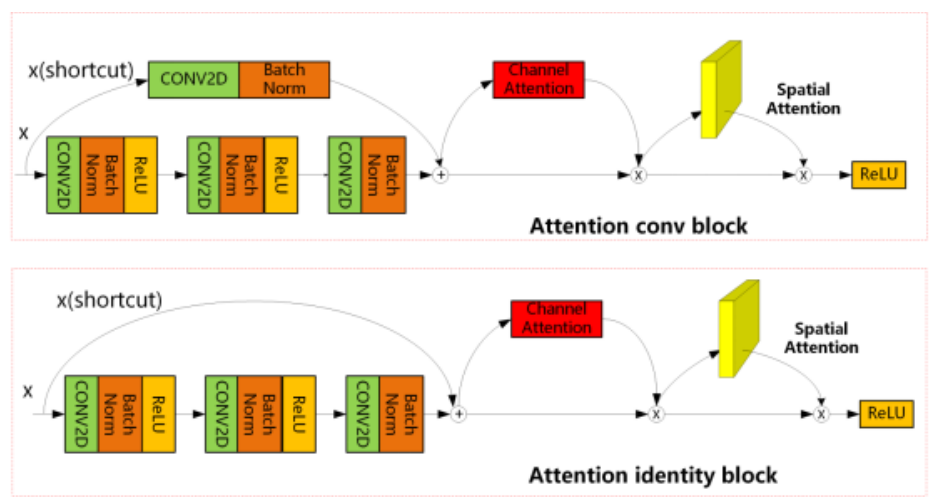
Figure 3. Attention conv block and Attention identity